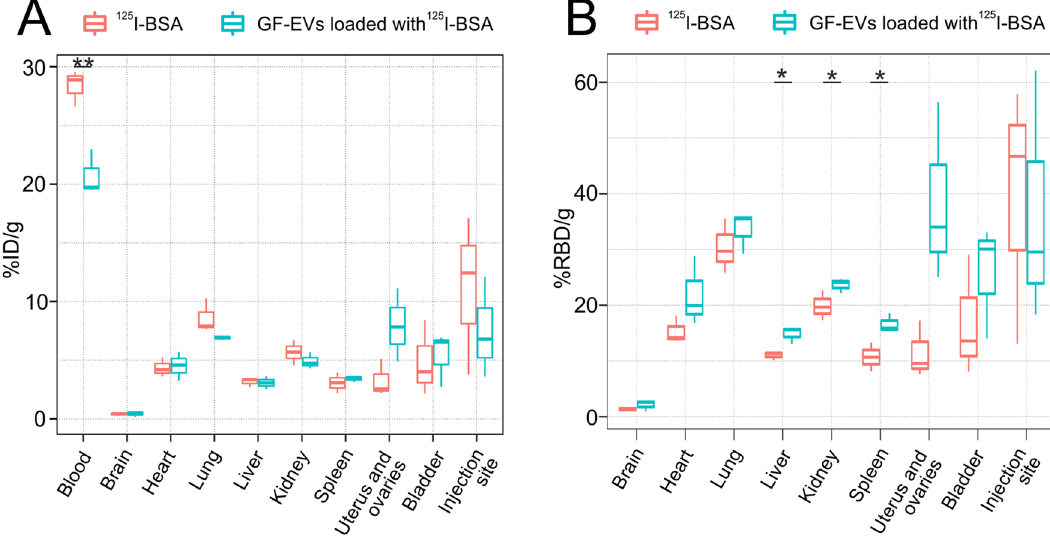
Figure 7. Biodistribution of GF-EVs loaded with 125 I-labeled BSA and free 125 I-BSA in mice 2 h after intravenous administration. Analysis of the radioactive protein abundance in different tissues expressed as a percentage of injected dose (ID) per gram of tissue ( A ) or as a percentage of relative blood dose (RBD) per gram of tissue ( B ). N = 3. Data are presented as means ± SD. *, p < 0.05; **, p < 0.01 as estimated by unpaired Student’s t-test